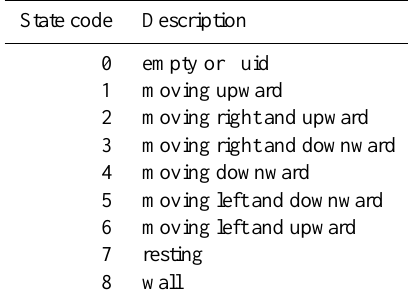
Table 1. States in the CTS lattice gas and lattice-grain